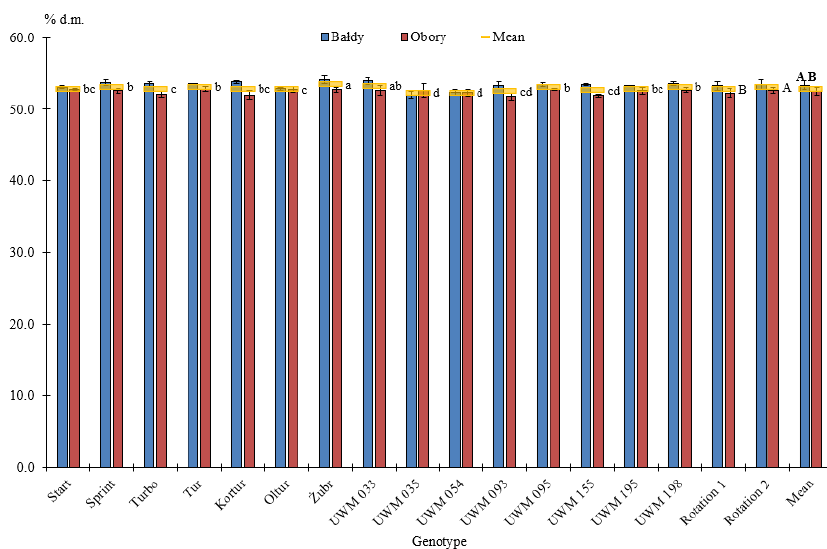
Figure 7. Carbon content in the biomass of 15 willow genotypes obtained at two locations in two consecutive three-year harvest rotations; (legend: see Figure 1). The H content in biomass was determined to the greatest extent by the interaction of location and genotype (38%), followed by the genotype (18%) and location (11%) (Table 2). The mean H content in willow biomass was 6.23% d.m. (Figure 8). The biomass obtained at Obory contained more hydrogen by approx. 2% (6.31% d.m.) compared to the biomass obtained at Bałdy. Among the 15 genotypes under study, the mean value of this characteristic ranged from 6.03% d.m. to 6.43% d.m., for the genotypes of UWM 155 ( S. dasyclados ) and UWM 093 ( S. acutifolia ). It was also shown in other studies that the hydrogen content in willow biomass was close to, or exceeded, 6% d.m. [10,36–38].